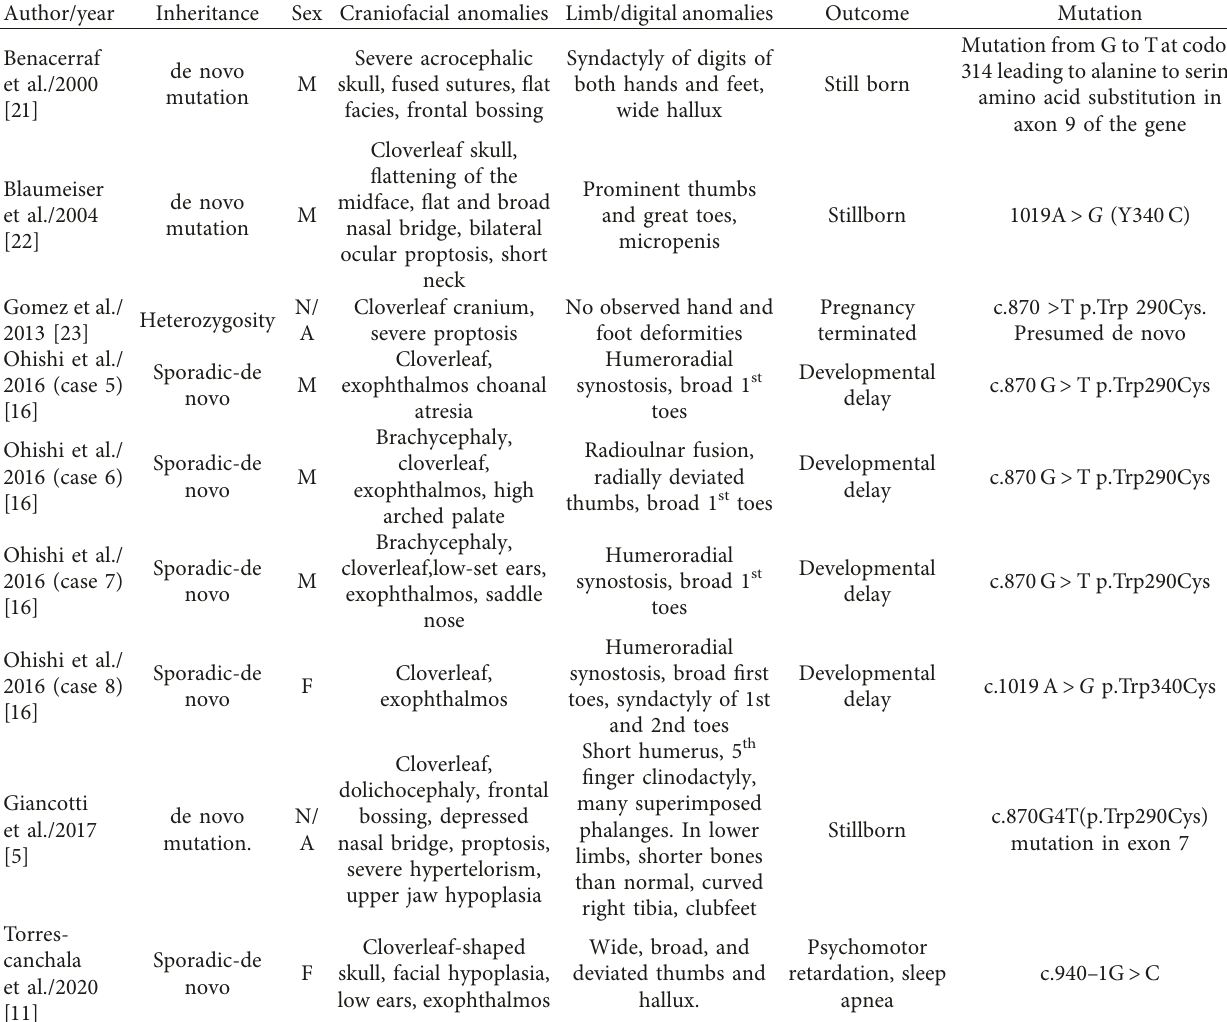
Table 1: De novo mutation reports of Pfeiffer syndrome type 2 involving the FGFR2